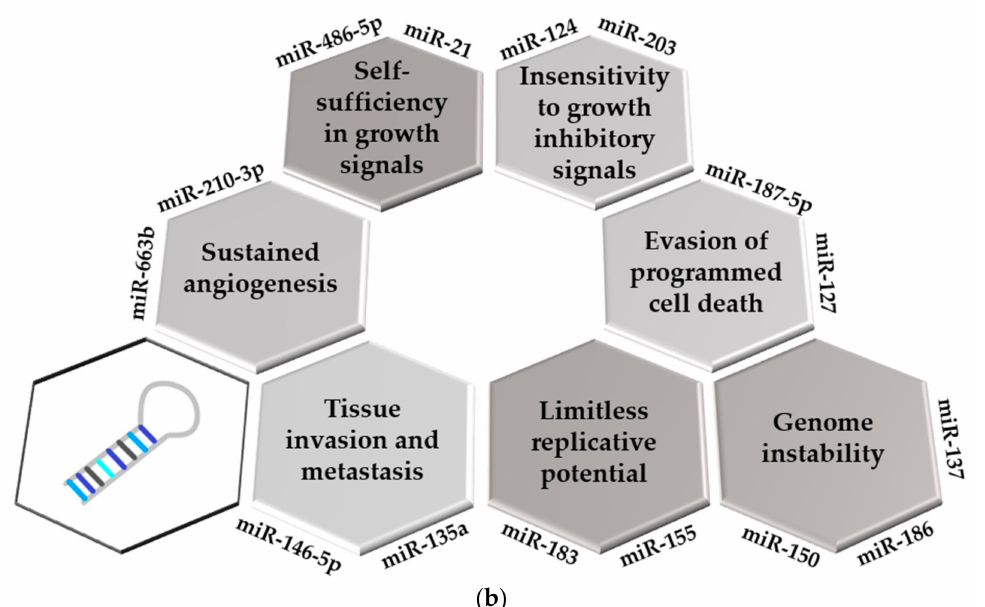
Figure 1. ( a ) Mechanisms of dysregulated miRNA expression in hematological malignancies. Ab- breviations: SNP: single nucleotide polymorphism, UTR: untranslated region. ( b ) Implication of miRNAs in the development of the hallmarks of